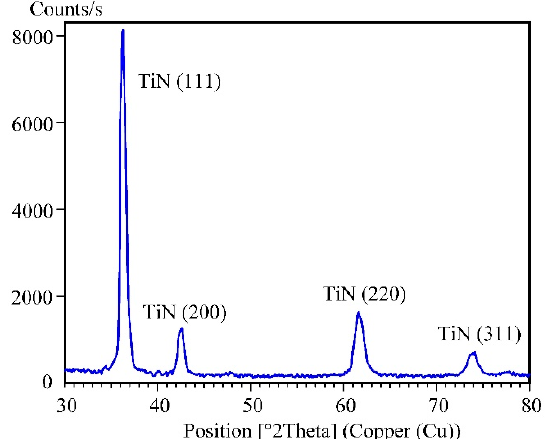
Figure 8. The X-ray diffraction pattern of the synthesized coating taken using the method of a grazing incident X-ray beam. incident X-ray